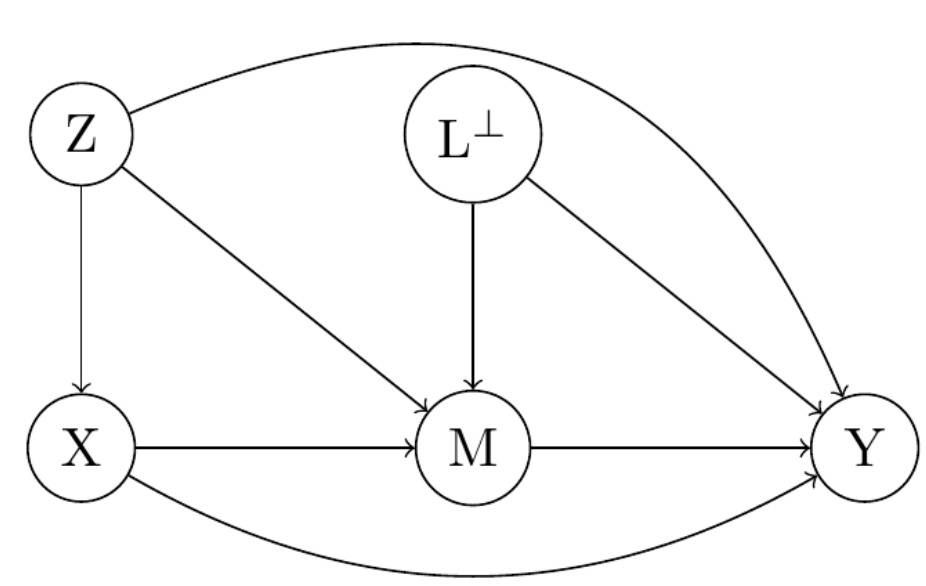
Figure 3: Causal relations between grandparent education (X), parental characteristics (M), and child cognitive ability (Y) in the presence of residualized post-treatment mediator–outcome confounders (L ⊥